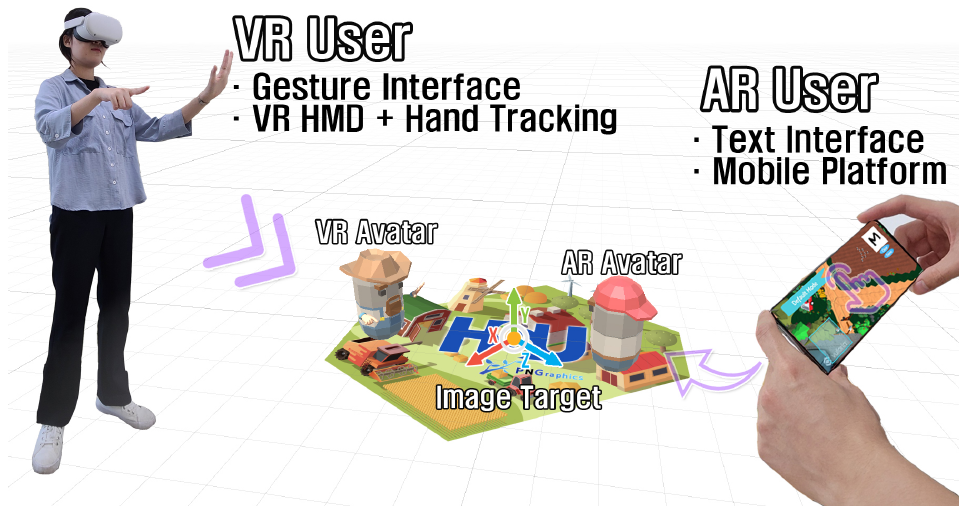
Figure 1. DAVE Configuration where VR and AR users participate